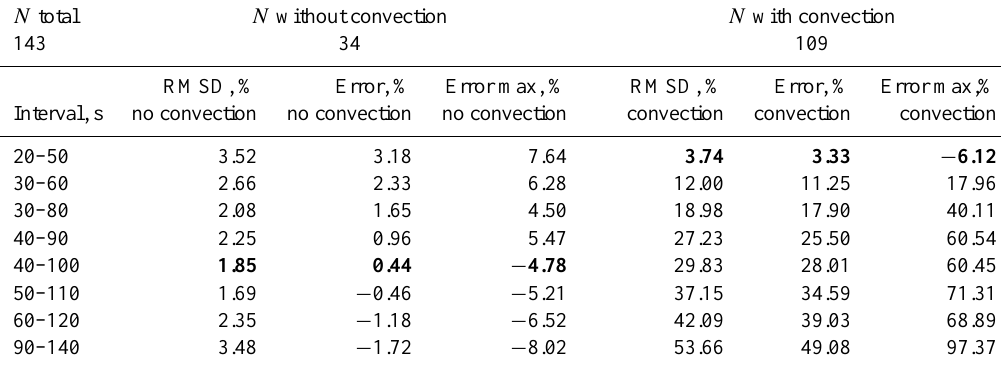
Table 1. Comparison between k eff values automatically ( k eff_auto ) extracted from different intervals, and values obtained from time intervals selected manually ( k eff_man ) , for the 2012–2013 winter. Data for cases with and without convection are analyzed separately. RMSD is the observed is also shown. Bold values correspond to the interval selected.